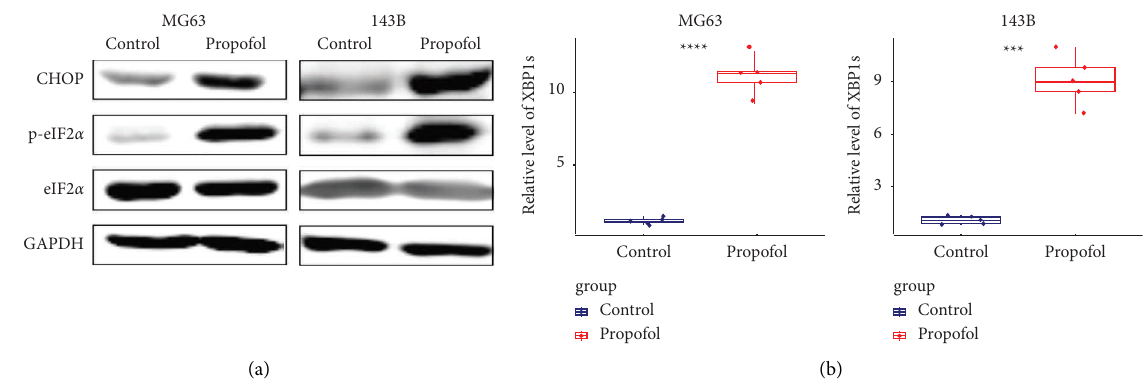
Figure 5: Propofol treatment-induced endoplasmic reticulum stress in osteosarcoma. Te protein levels of CHOP and p-eIF2 α were signifcantly increased after propofol treatment in MG63 and 143B (a). Upregulated mRNA expression of XBP1s was detected in MG63 and 143B after propofol treatment